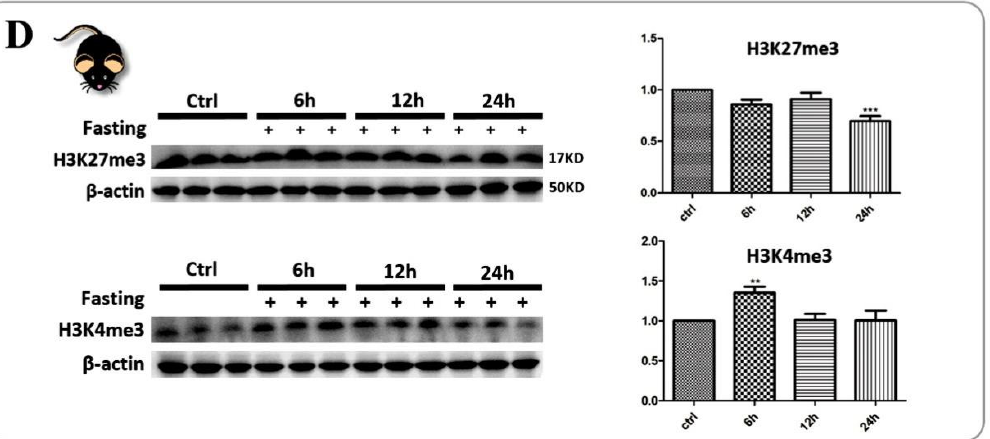
Figure 2. Integrative analysis of the proteomics dataset pinpointed H3K27me3 and H3K4me3 as hubs. ( A ) Proteomics data from our study and transcriptomic data from references overlapped. Left, genes that showed a consistent increase or decrease in both RNA and protein levels are highlighted by red and blue columns, respectively; right, the network that was generated using the STRING database by loading consistently changed genes as seeds which constitute nodes of a protein inter‑ action network. Among them, yellow nodes represent genes related to neurodegenerative disease like AD, PD and HD. ( B ) Up, the protein‑protein interaction model used to identify hub proteins. Down, the protein‑protein interaction network, was seeded with AD, PD, HD, Epilepsy, ASD, and ALS candidate proteins identified in our dataset (Supplementary Table S2); highlighted by red nodes. Blue nodes indicate intermediate protein‑protein interactions between seed genes. Green nodes represent proteins connected to the top hub protein of high degree and/or betweenness centrality. ( C ) Western blot analysis ( n = 3), left, revealed that 3OHB induced a significant reduction of H3K27me3 levels in the HT22 cells upon long‑term treatment (at 12 h ( p < 0.01) and 24 h ( p < 0.001)); right, the levels of H3K4me3 in the HT22 cells were increased after 12 h of treatment ( p < 0.01). ( D ) Western blot analysis ( n = 6), left, revealed that fasting induced a similar pattern of H3K27me3 level reduction in the brains of C67 mice at 24 h ( p < 0.001) comparable to that of HT22 cells; right, H3K4me3 levels showed an earlier response at 6 h of fasting ( p < 0.01) than what was observed upon 3OHB treatment in HT22 cells. Data are mean ± SEM n = 3 ( C ); Data are mean ± SEM n = 6 mice per group ( D ), one‑way ANOVA, Tukey’s test, ** means p < 0.01 while *** means p < 0.001 ( C , D